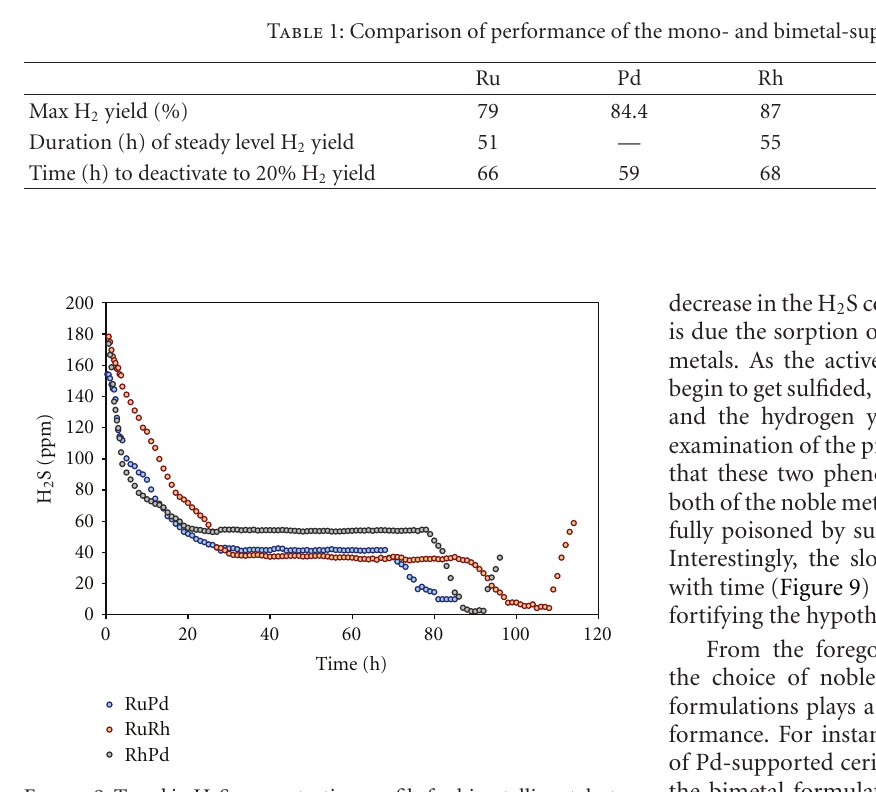
Figure 9: Trend in H 2 S concentration profile for bimetallic catalysts with time